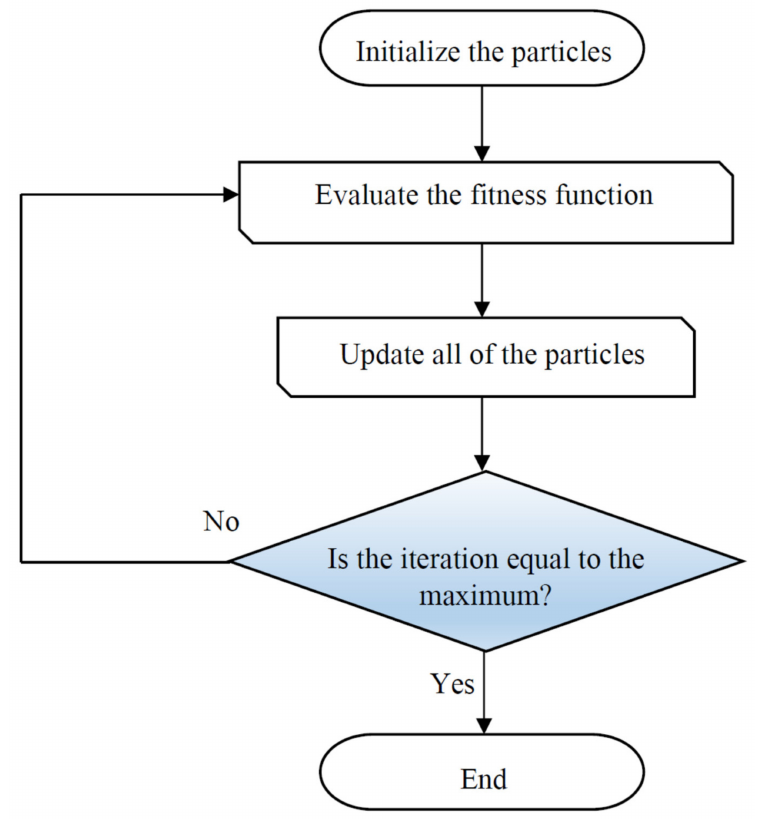
Figure 4. Schematic of the main steps used in the particle swarm optimization (PSO)